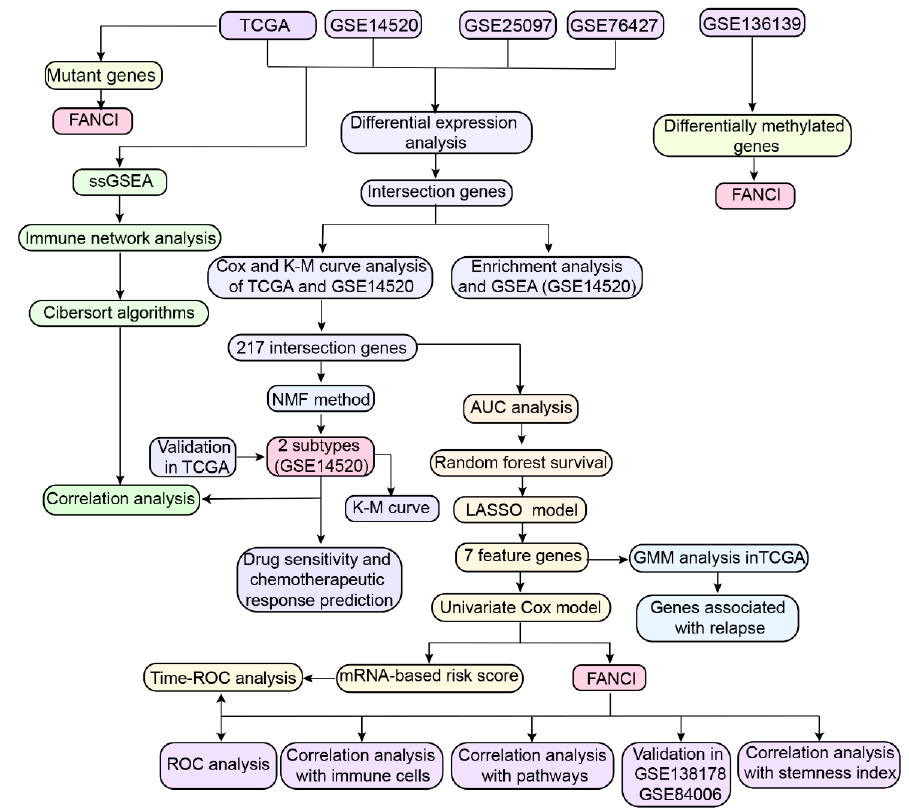
Figure 1. Study workflow. AUC, area under the receiver operating characteristic (ROC) curve; DEG, differentially expressed genes; GMM, gaussian mixture model; KM, Kaplan-Meier; LASSO, least absolute shrinkage and selection operator; NMF, nonnegative matrix factorization; OS, overall survival; TCGA, The Cancer Genome Atlas; GEO, Gene Expression Omnibus; ssGSEA, single-sample gene set enrichment analysis.